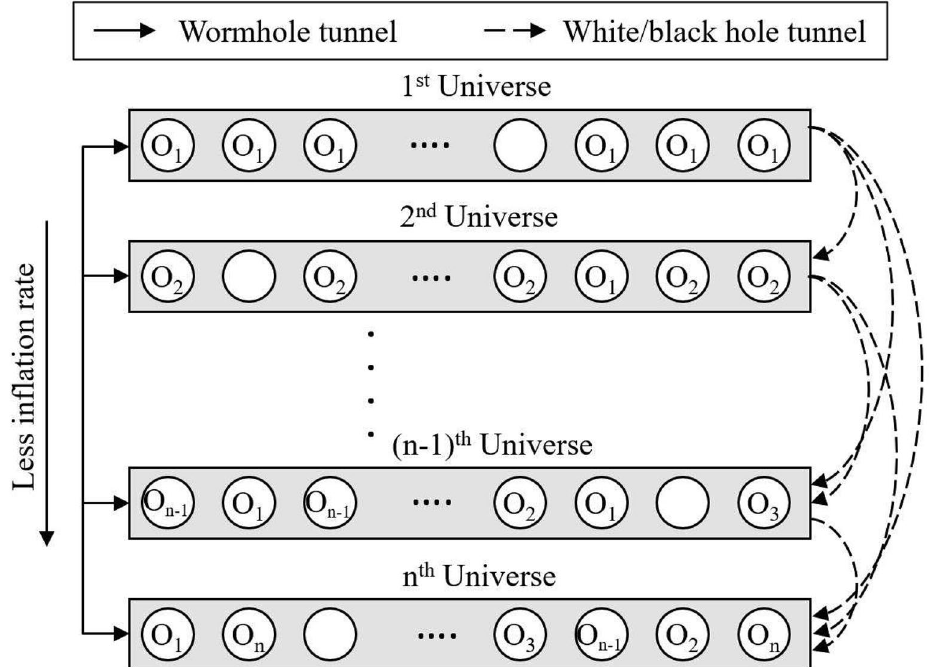
Figure 1. Conceptual model of the proposed MVO